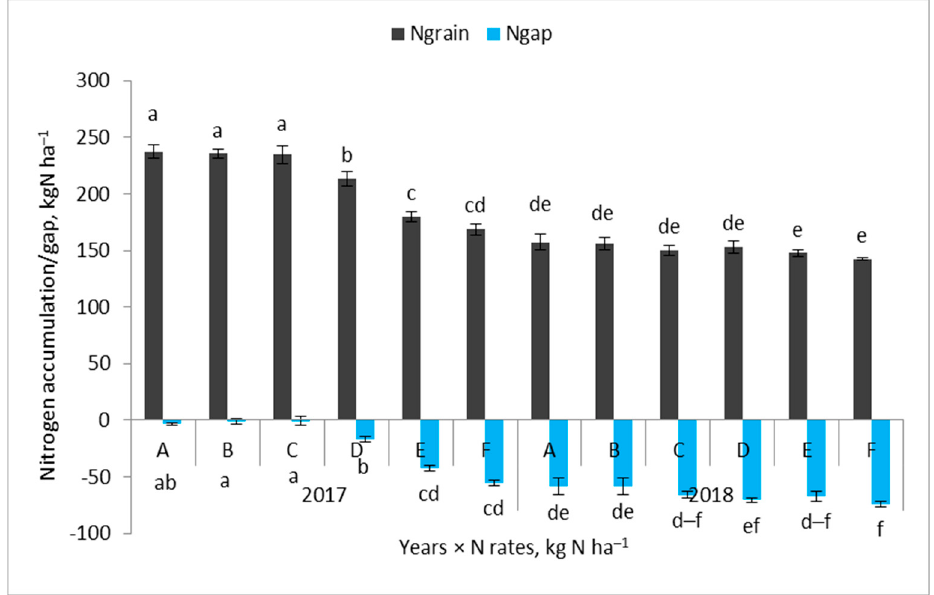
Figure 6. Effect of plant protection methods on nitrogen accumulation in grain and on nitrogen gap. Similar letters indicate a lack of significant differences between experimental treatments using Tukey’s test. The vertical bar in the column is the standard error of the mean.